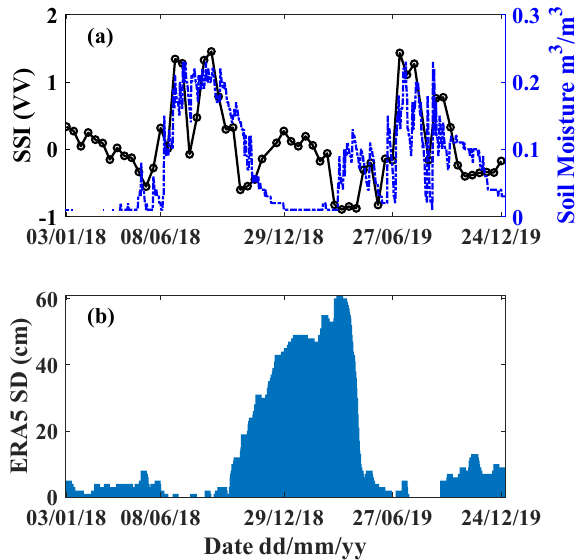
Figure 10. Time series of the SSI S1B , in situ soil moisture and ERA5-land snow depth at site MS3527 over the Naqu area. ( a ) Time series of the SSI S1 (black line marked with a black circle) and in situ soil moisture (blue dashed line); ( b ) time series of ERA5-land snow depth.